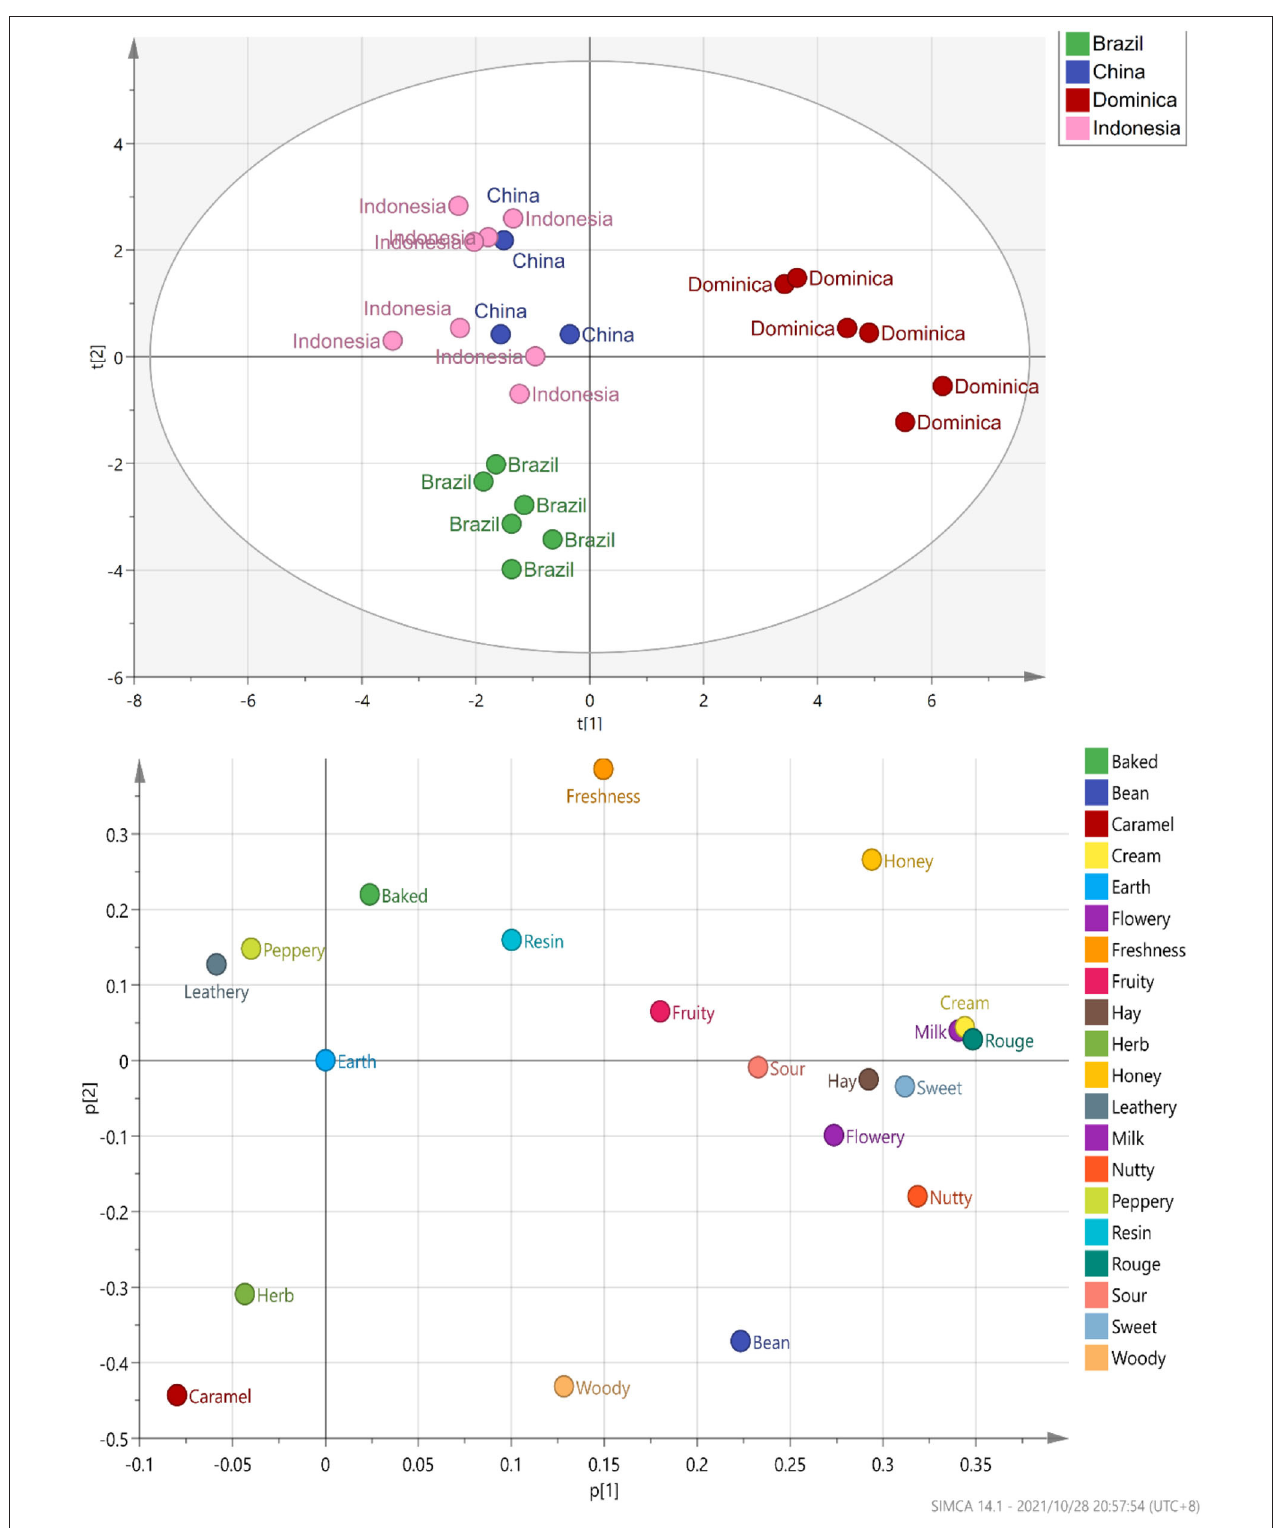
FIGURE 8 | PCA plot marked by sensory analysis score of cigar tobacco